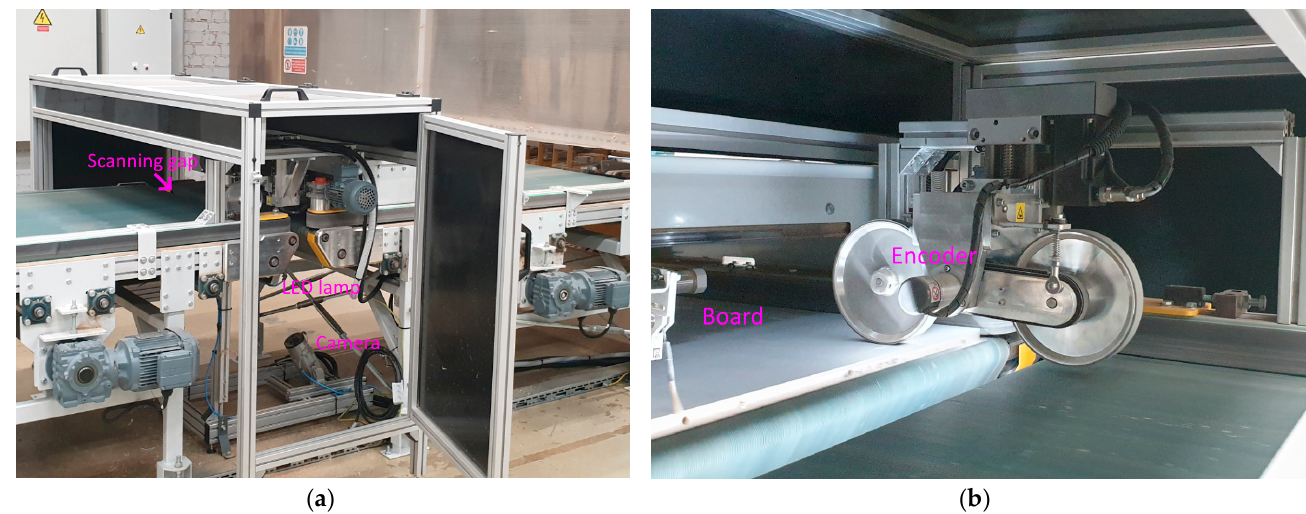
Figure 17. Image capture setup: ( a ) vision inspection box, ( b ) board scanning place. The camera is triggered with an encoder that is rotated by a roller that pushes down the furniture board.